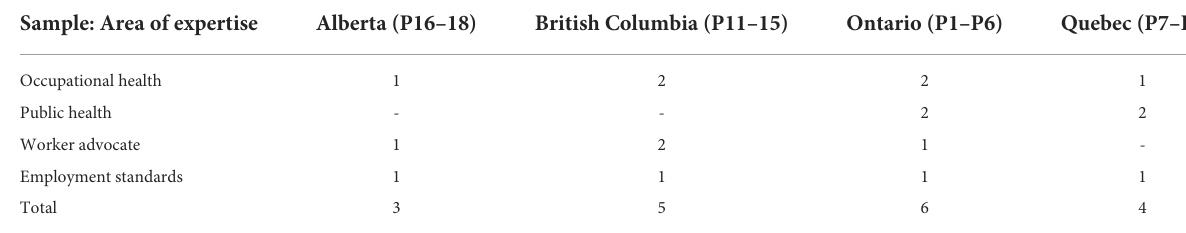
TABLE 1 Sample areas of expertise per province.